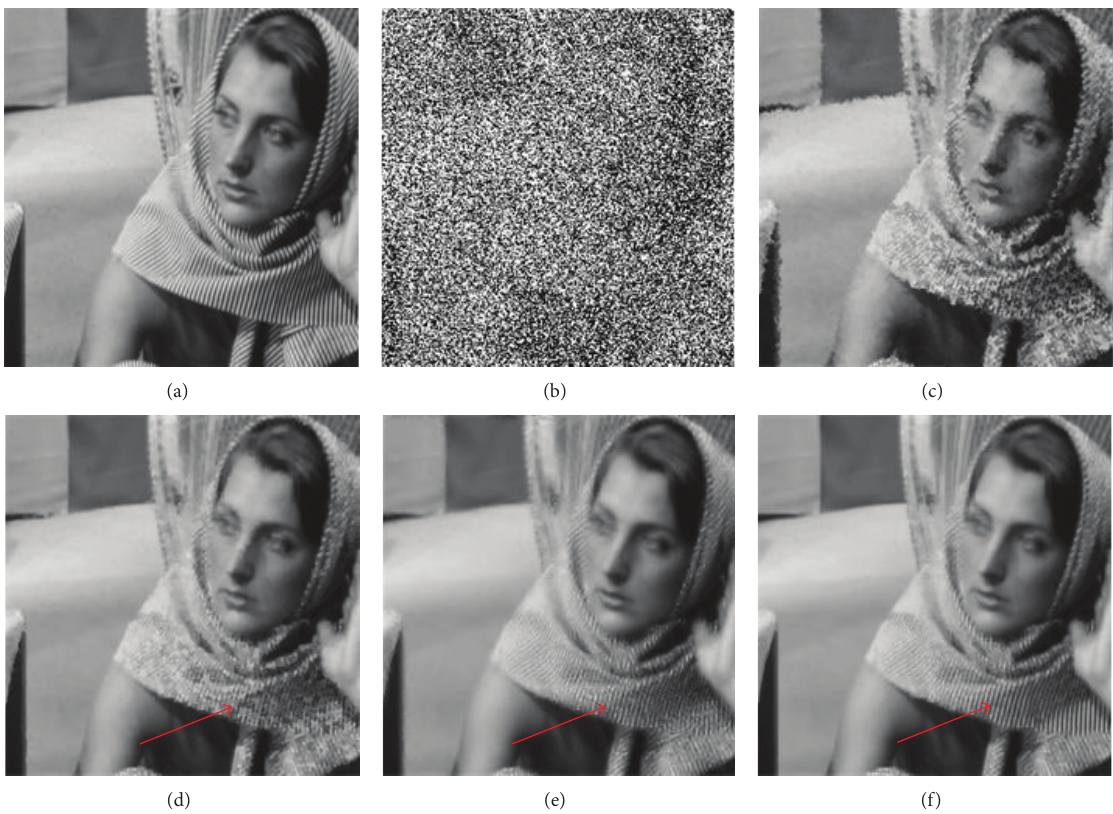
Figure 8: Reconstructed Barbara images from70% saltand pepper impulsenoise. (a)Noise-freeimage, (b)noisy image, (c)–(f)reconstructed images using AMF, TV-ND, Wavelet-ND, and PANO-ND,